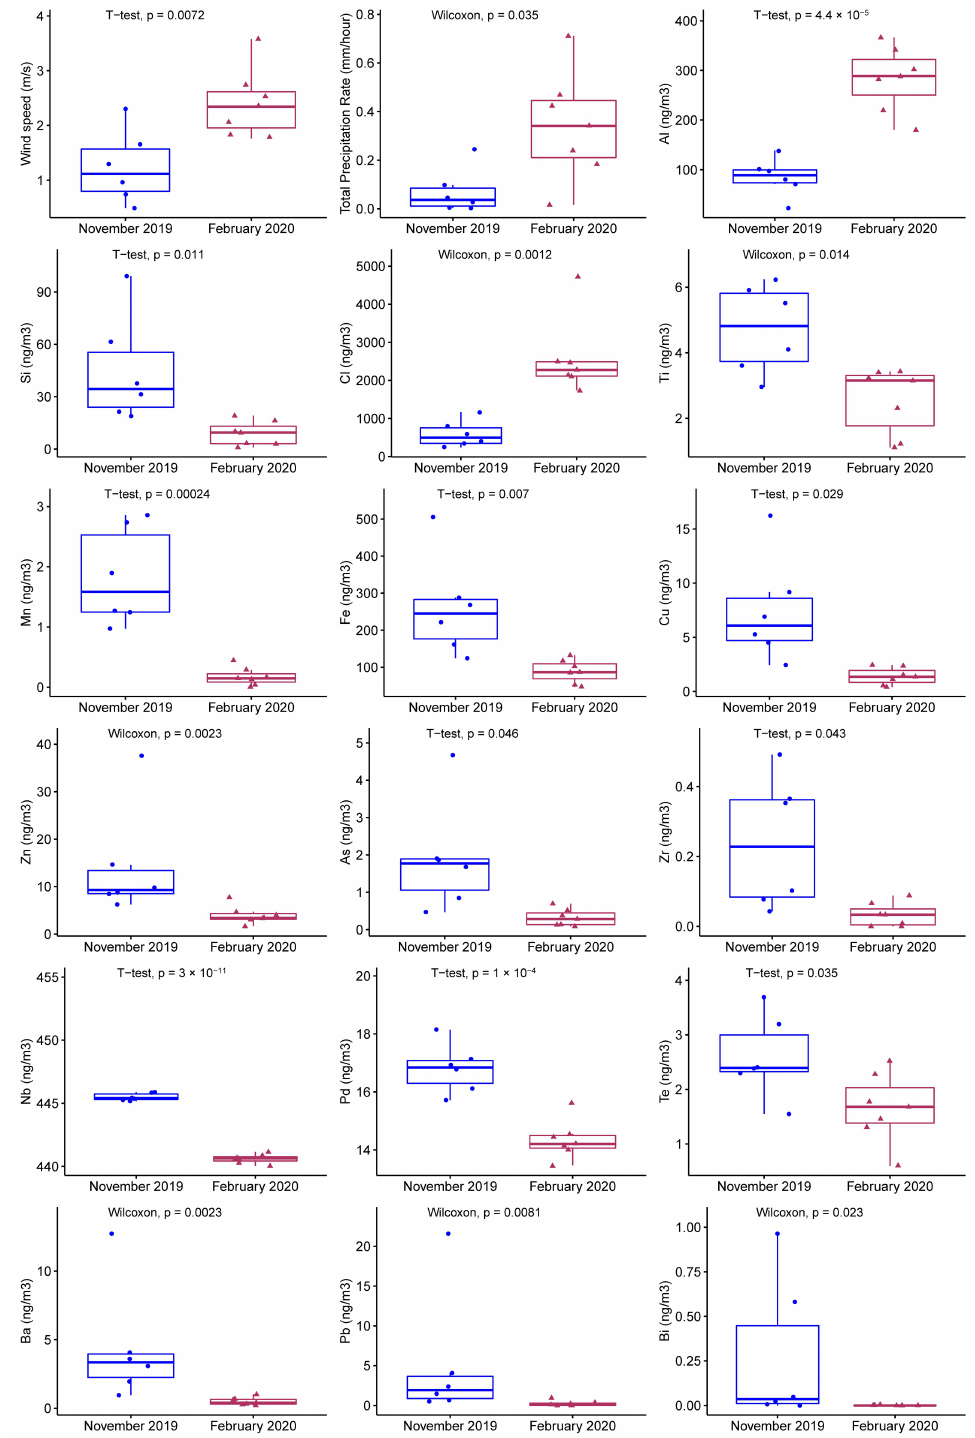
Figure 1. Boxplots of environmental parameters that were significantly different between November 2019 samples and February 2020